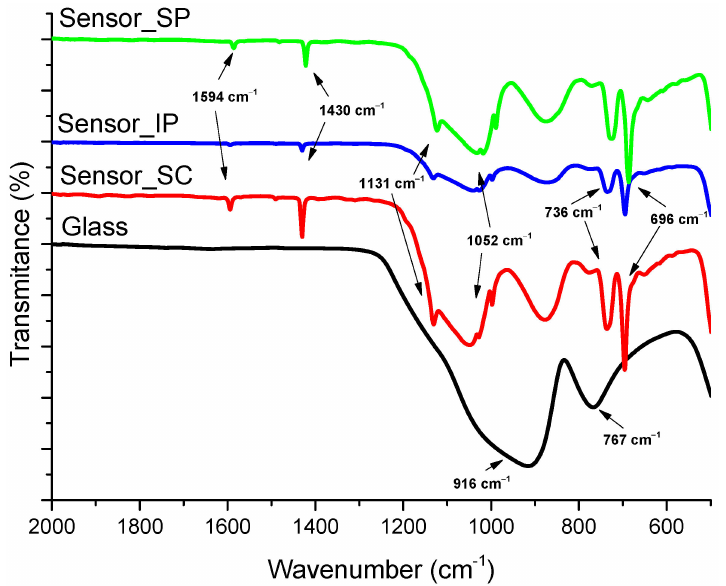
Figure 3. FTIR spectra of pure glass substrates without application of the sol-gel solution (pure glass—black line) and sol-gel coated glass substrates: spin coating (SC—red line), inkjet printing (IP—blue line), and spray coating (SP—green